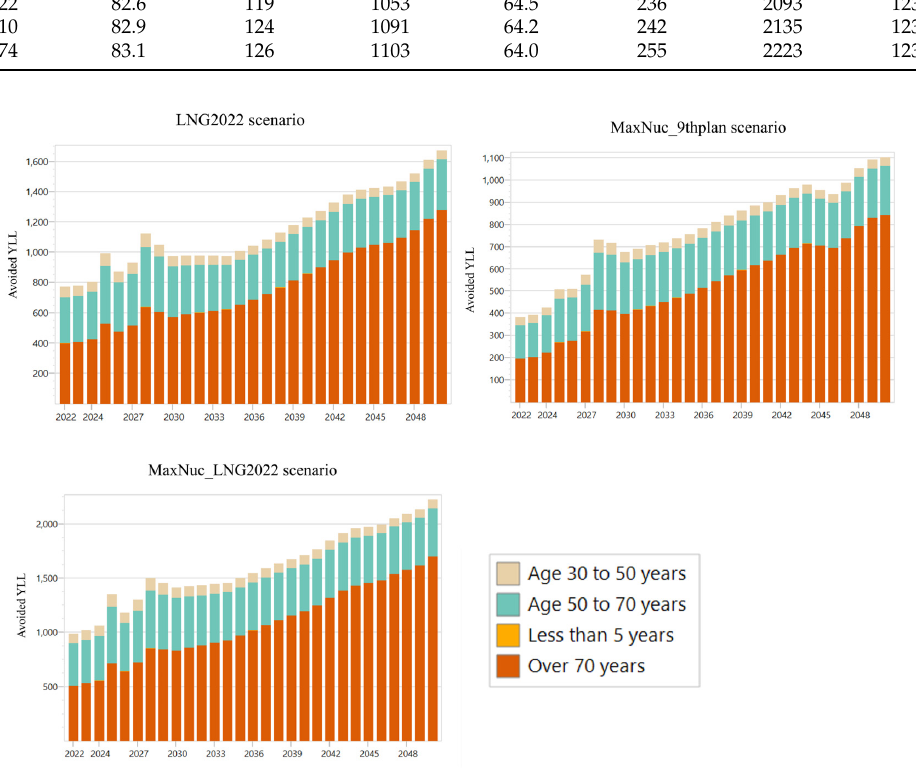
Figure 8. Avoided YLL for each scenario compared to baseline by year.